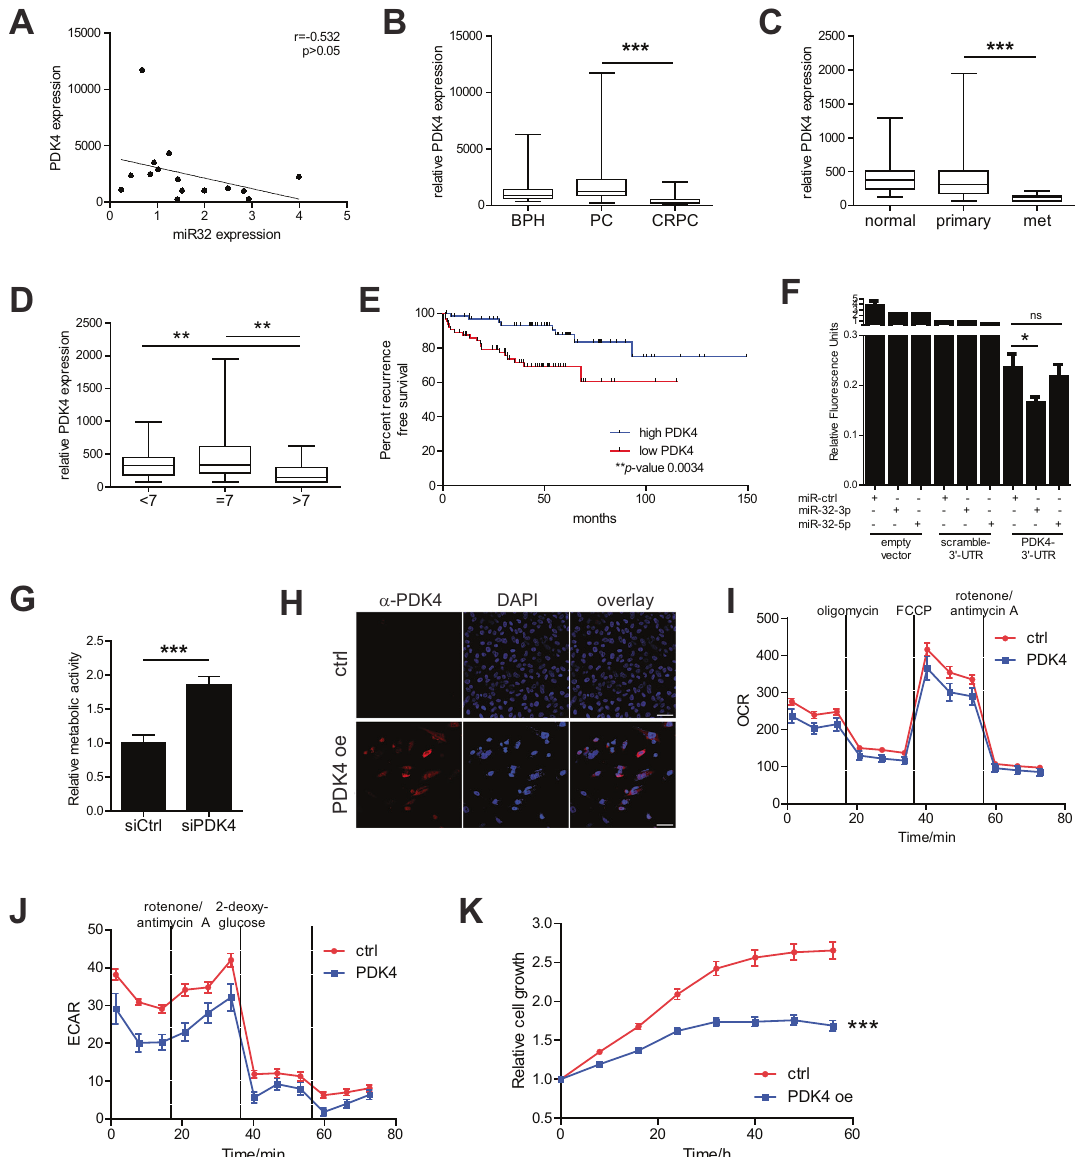
Fig. 4 PDK4 is a prostate cancer-relevant target of miR-32. A Correlation analysis of PDK4 expression de fi ned by RNA-seq [31] and miR-32 expression de fi ned by RT-qPCR in 15 human primary PC samples show an inverse correlation between the expression of these genes. B RNA expression analysis in prostate tissue samples of BPH, primary cancer (PC), and CRPC in the Tampere patient cohort showed decreased PDK4 expression in CRPC compared to PC. C RNA expression analysis in prostate tissue samples of normal, primary cancer, and metastases including both non-castrate and castration-resistant samples in the Taylor et al. [46] patient cohort showing decreased PDK4 expression in metastatic compared to PC samples. D RNA expression analysis in prostate tissue samples of primary PC samples in the Taylor et al. [46] patient cohort showing relatively decreased PDK4 expression in samples with higher Gleason grades. E Survival proportions of patients with primary PC in the Taylor et al. [46] data set between tumors of high and low PDK4 expression show decreased recurrence-free survival for patients with low PDK4-expressing tumors. F Luciferase assay in HeLa cells transfected with control (no-UTR, scramble-3 ′ -UTR) and PDK4-3 ′ UTR luciferase constructs and the indicated pre-miRNAs showing targeting of PDK4-3 ′ -UTR construct targeting by pre-miR-32-3p. G Downregulation of PDK4 expression increases the relative metabolic activity as de fi ned by Alamar Blue assay of 22Rv1 PC cells. H Immuno fl uorescence analysis of PC-3 cells transiently transfected with PDK4 (PDK4 oe) compared with cells transfected with the control plasmid (ctrl). Staining with α -PDK4 antibody shows no expression of endogenous PDK4 protein in PC-3 cells and positive PDK4 signal at 3 days after transfection. DAPI nuclear staining is shown for reference. Scale bar, 50 µm. I Oxygen consumption rate in PC-3 cells transfected with control (ctrl) or PDK4-expressing plasmids showing decreased basal and maximum mitochondrial respiration rate in PDK4 overexpressing cells. J Extracellular acidi fi cation rate in PC-3 cells transfected with control (ctrl) or PDK4-expressing plasmids showing decreased basal and maximum glycolytic rates. K PC-3 cells transiently transfected with PDK4 (PDK4 oe) show decreased growth compared to cells transfected with the control plasmid (ctrl). Error bars, standard deviation ( F , G ), SEM ( I – K ). p values *<0.05, **<0.01,